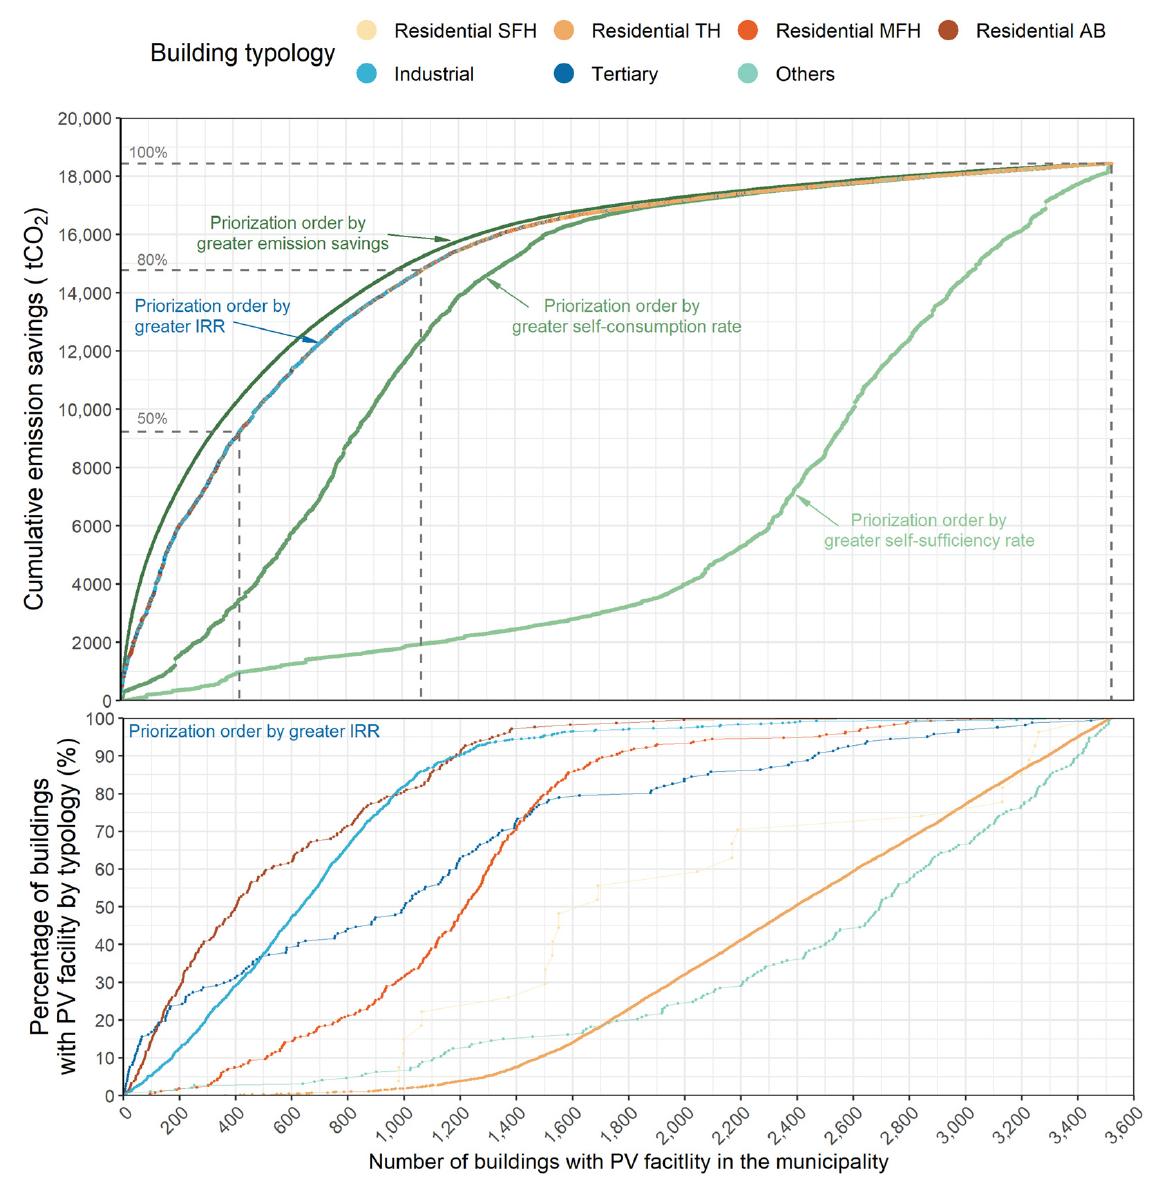
Figure 8. Cumulative potential emission savings prioritizing installations on buildings by greater IRR , SC and SS .